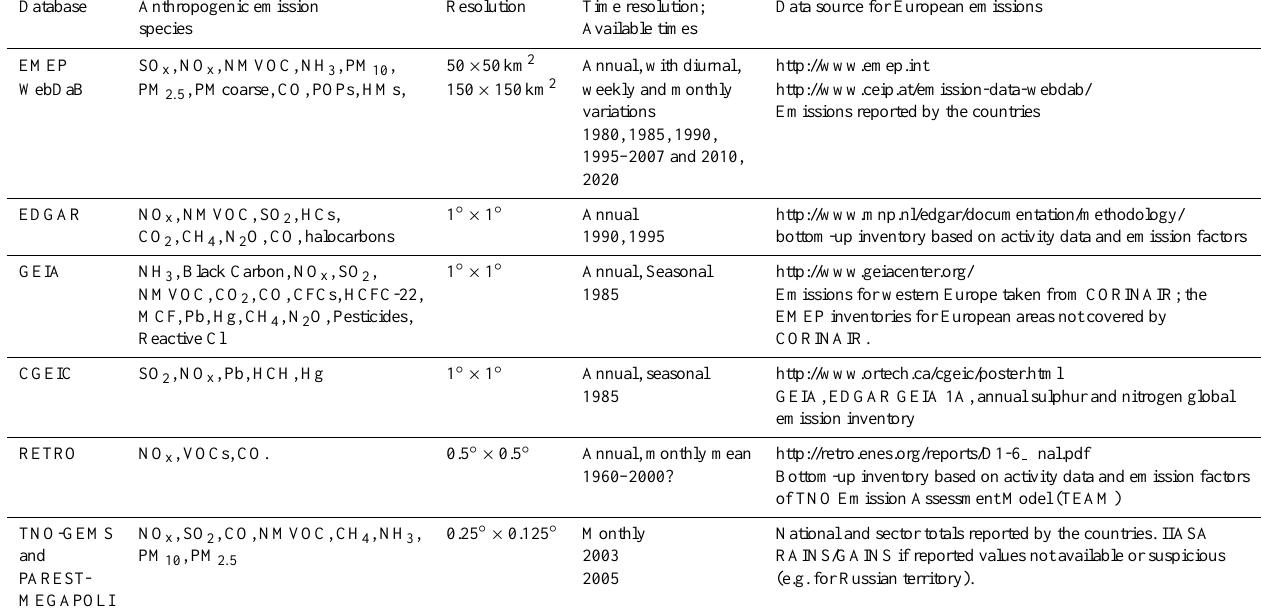
Table 2. The summary of the databases for anthropogenic emissions in Europe.